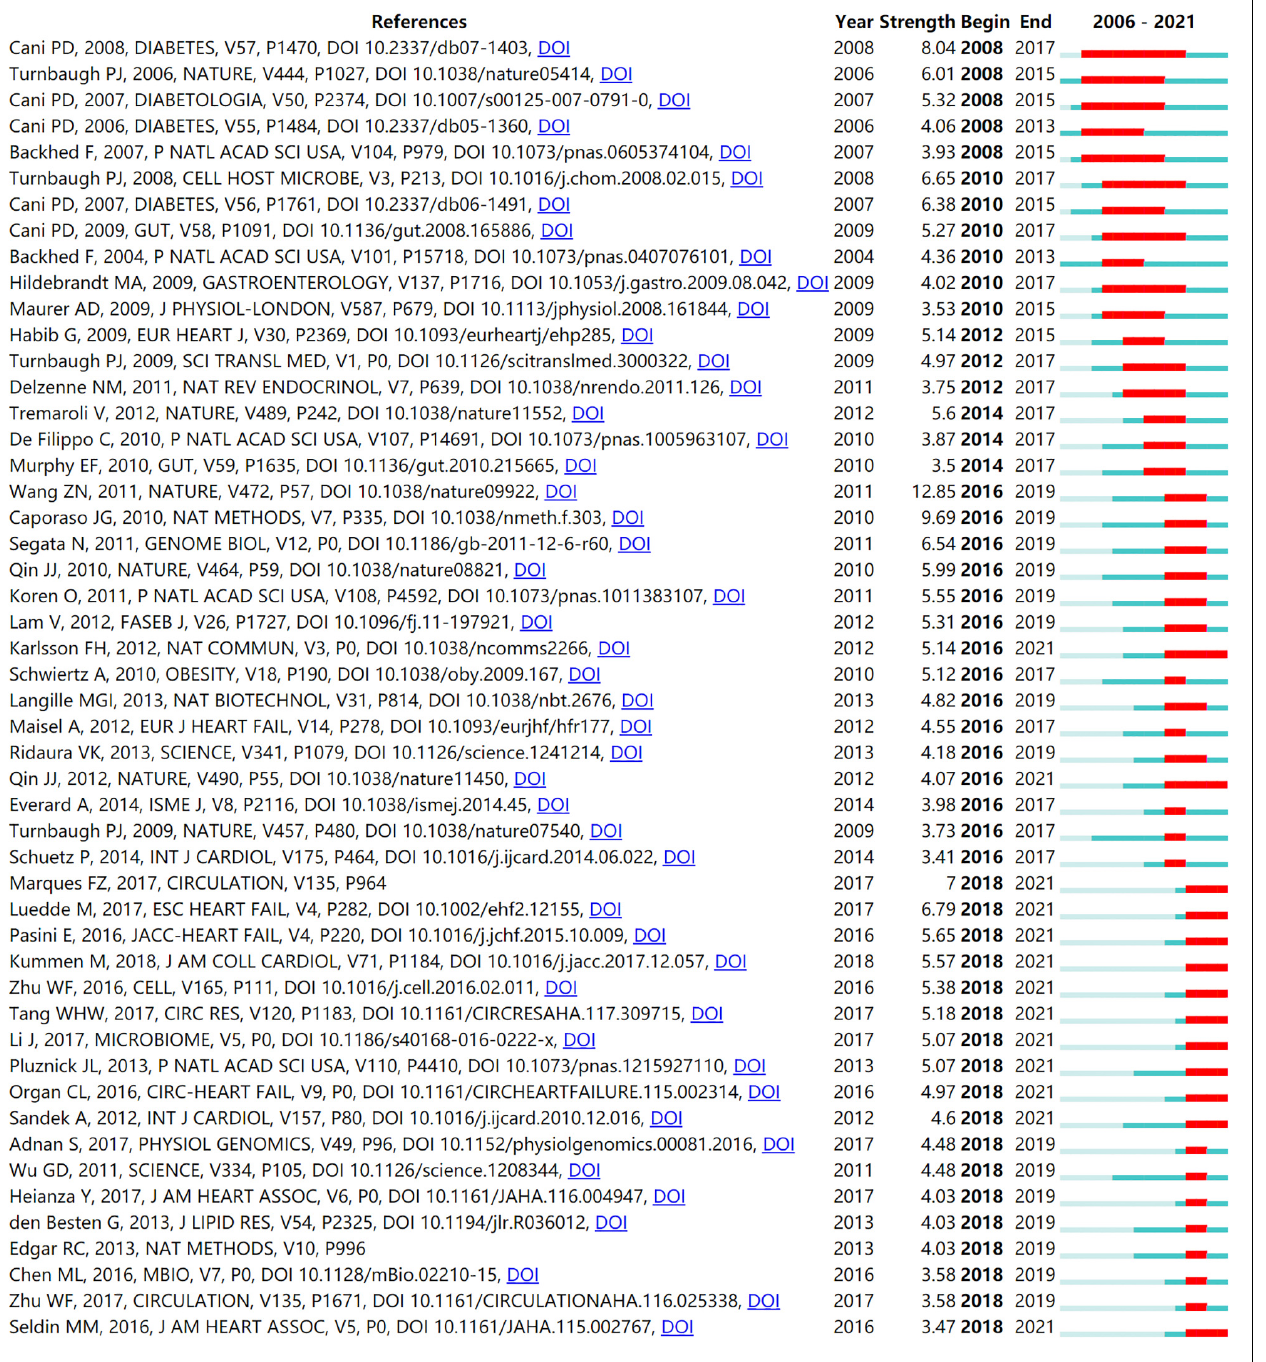
microbial ecology and host physiology in animals and